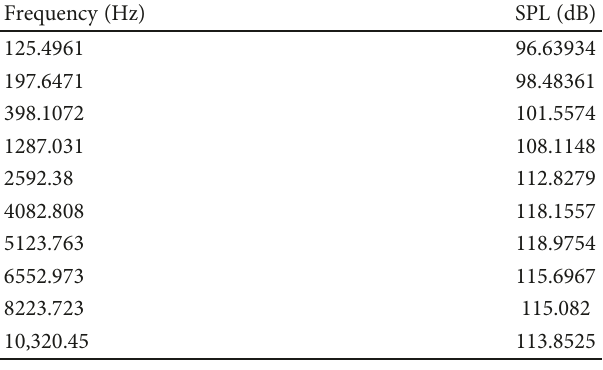
Table 6: Supersonic jet noise spectrum experimental data [37]. Frequency (Hz)